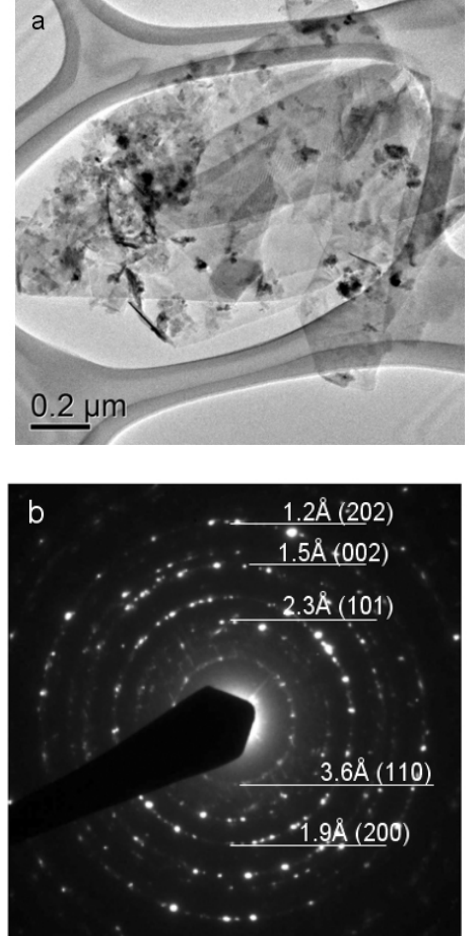
Figure 5. (a) EDS spectrum and (b) HREM image of hematite